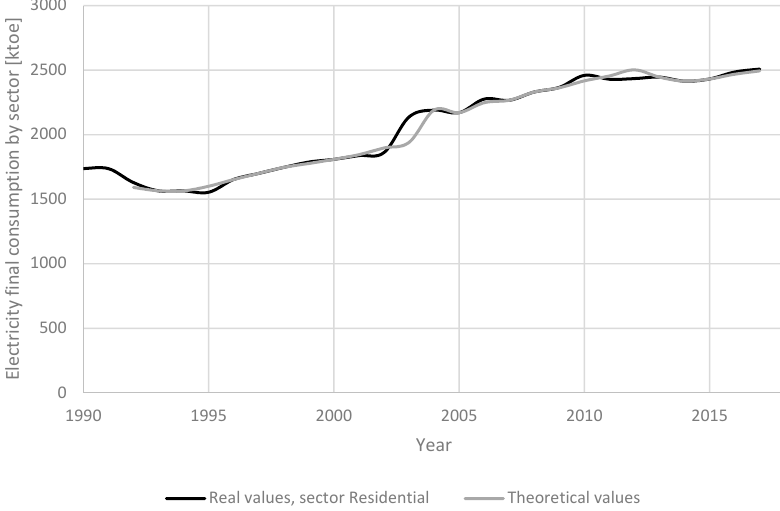
Figure 9. The comparison of the theoretical and actual values of final electricity consumption for transport sector, ktoe, source: own study.